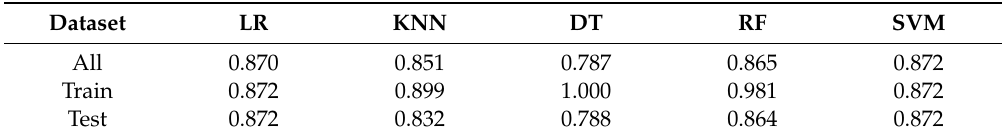
Table 3. Accuracy values for all prediction models.